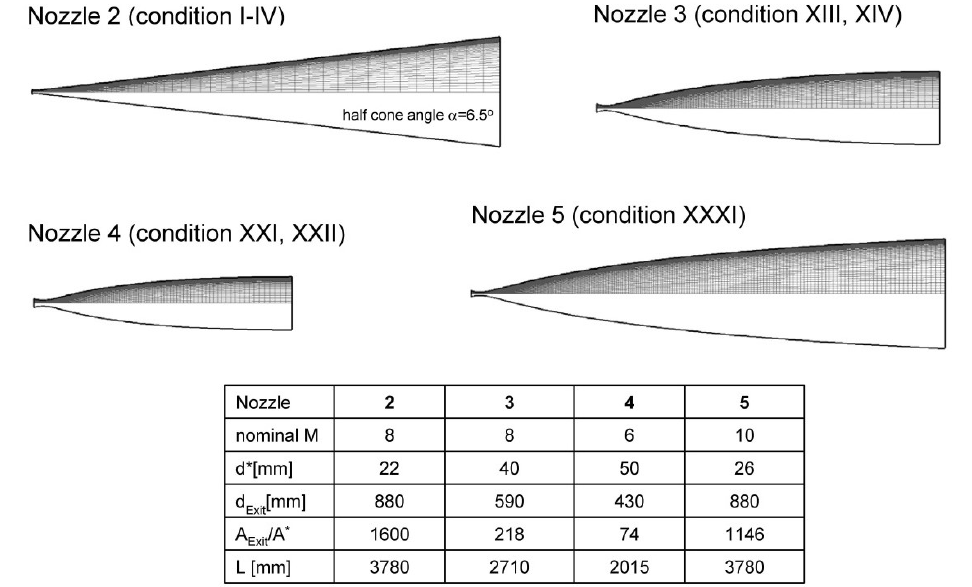
Figure 6: Geometries of the HEG nozzles.